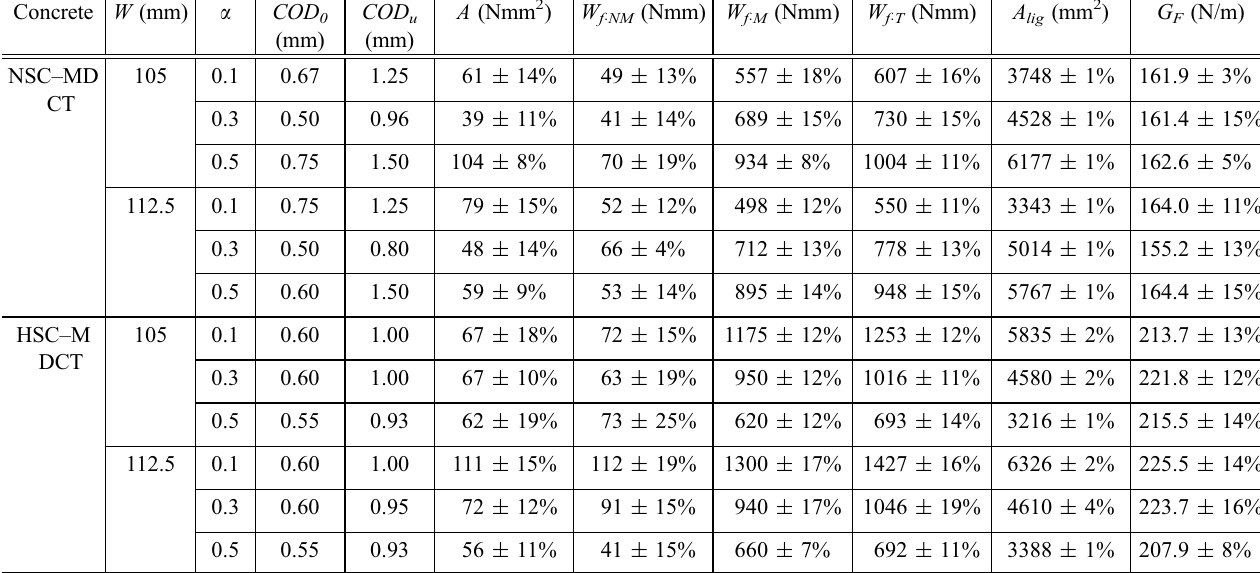
Fig. 12 a P - COD curve corresponding to the MDCT test for W = 112.5 mm and a = 0.5. b Proposed tail fitting for the P - COD curve after removing the affected part. Table 5 Results from MDCT tests.